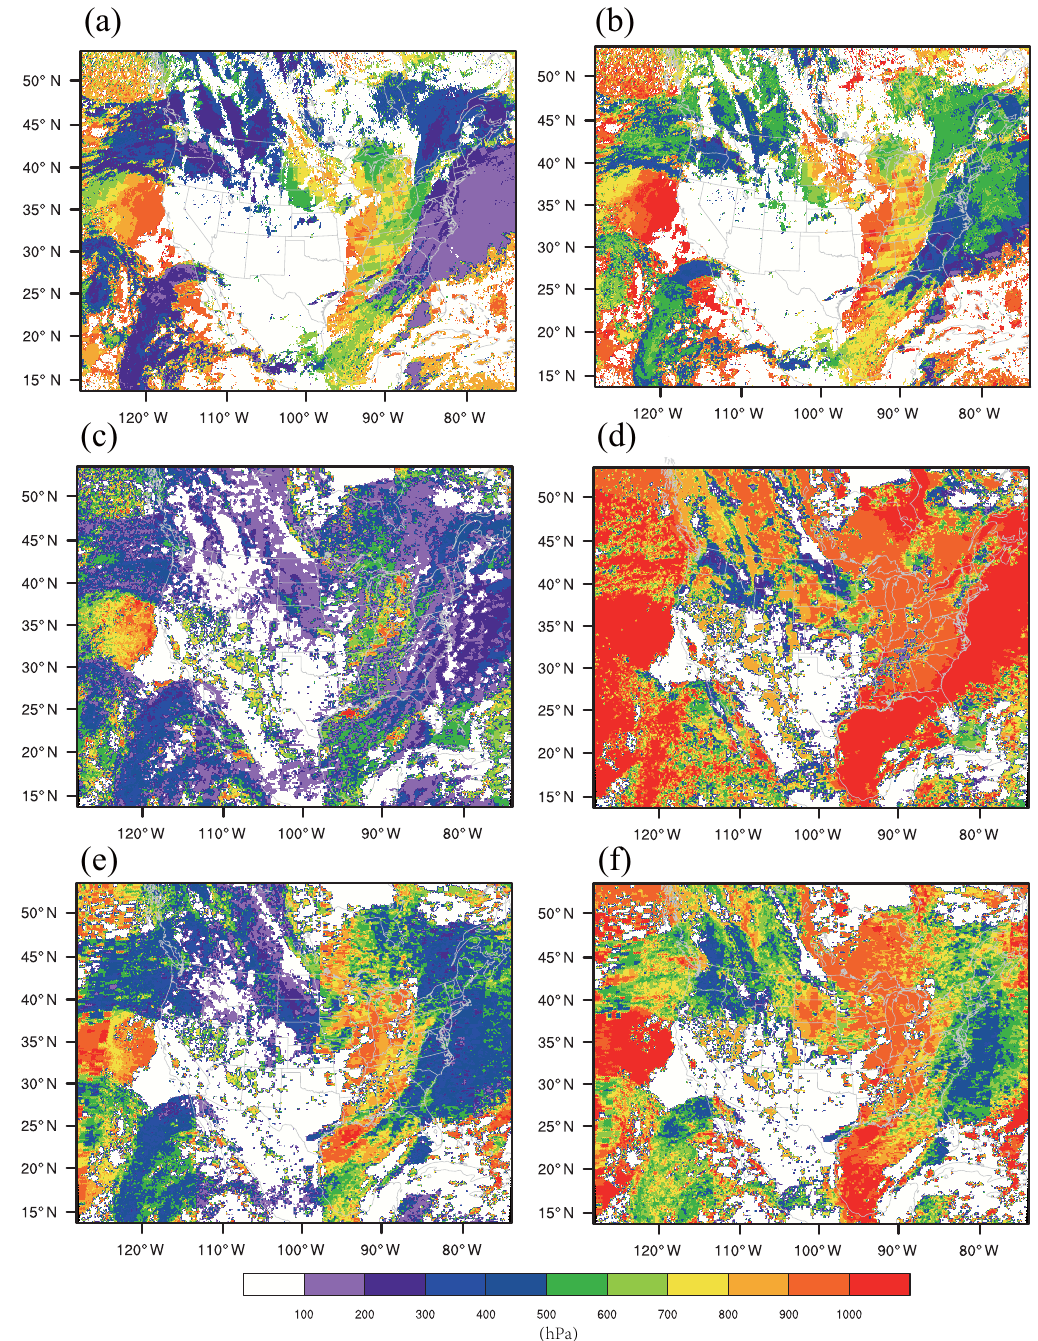
Figure 7. The cloud top pressure (left panels) from (a) the NASA GOES retrieval, (c) the MMR method and (e) the APF method, and the cloud bottom pressure (right panels) from (b) the NASA GOES retrieval, (d) the MMR method and (f) the APF method valid at 07:00UTC, 15 December